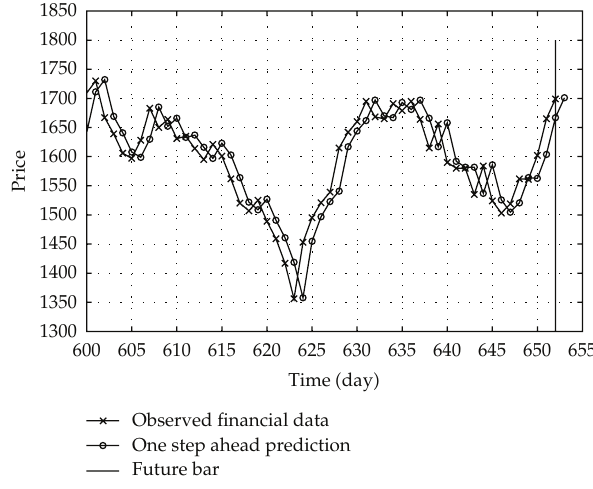
Figure 7: One-step-ahead prediction for single channel (cid:2) channel-2 (cid:3) financial time series.